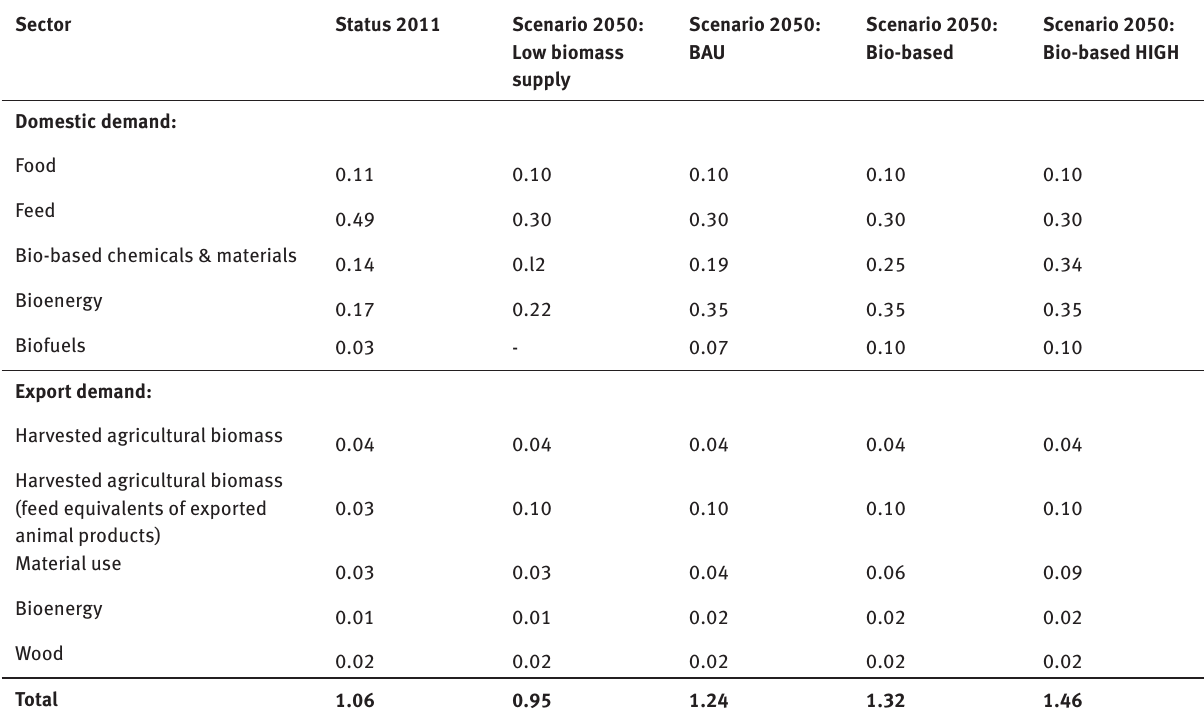
Table 4: Biomass demand of the EU-27, 2011 and 2050, in different scenarios, in billion tonnes dry matter (based on Piotrowski et al. 2015)